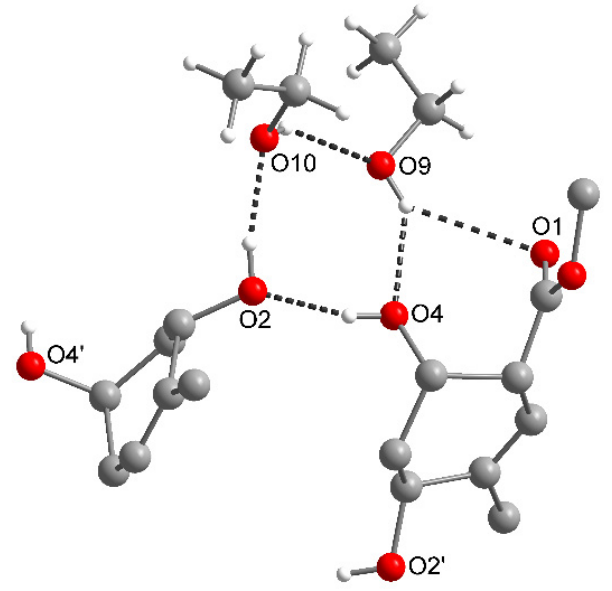
Figure 4. Four-membered cyclic hydrogen bond motif between two moxidectin molecules (only fragments shown) and two ethanol solvent molecules. Selected distances O1–O9 3.255(4) Å, O2–O4 2.760(2) Å, O2–O10 2.700(3) Å, O4–O9 2.782(4) Å, O9–O10 2.719(5) Å. Colour code: C, grey; N, blue; O, red; H, white.